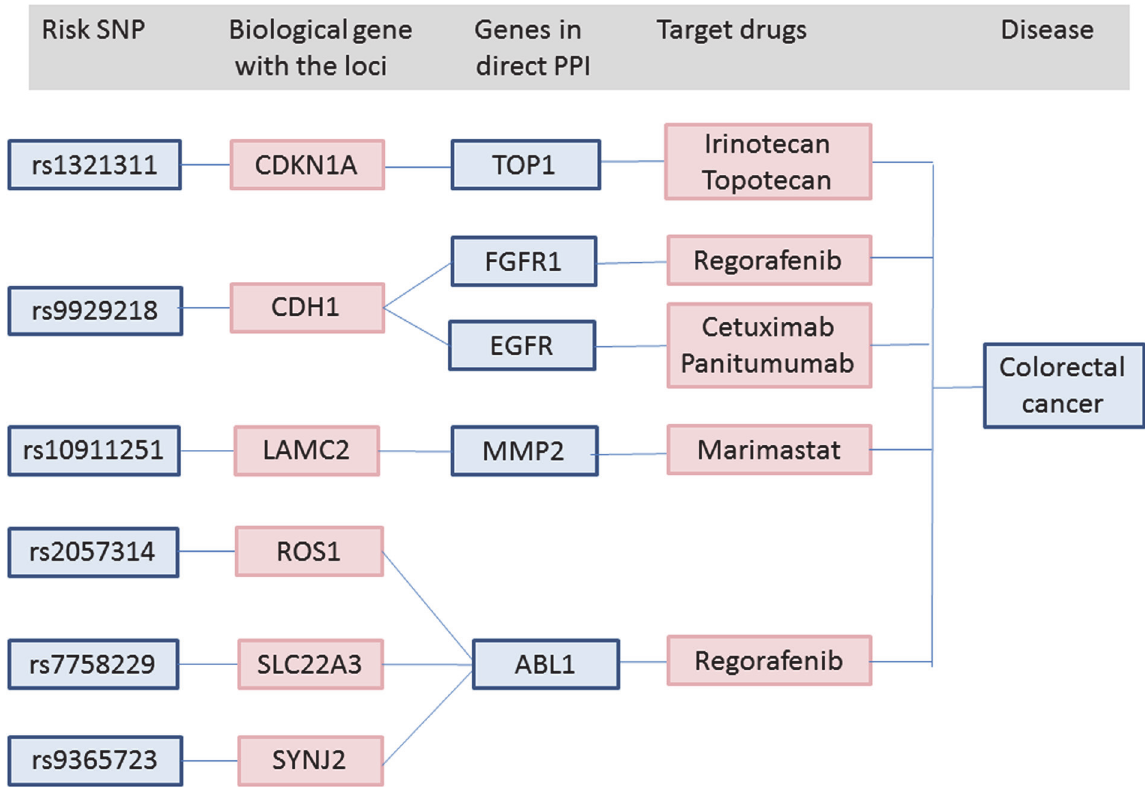
Fig 2. Summary of connections between risk SNPs, biological candidate genes from each risk locus, genes from the PPI network and approved CRC drugs. Black lines indicate connections.